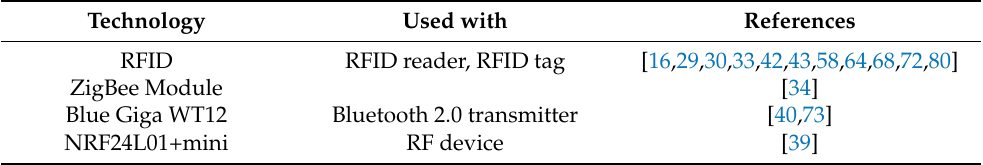
Table 3. Used wireless